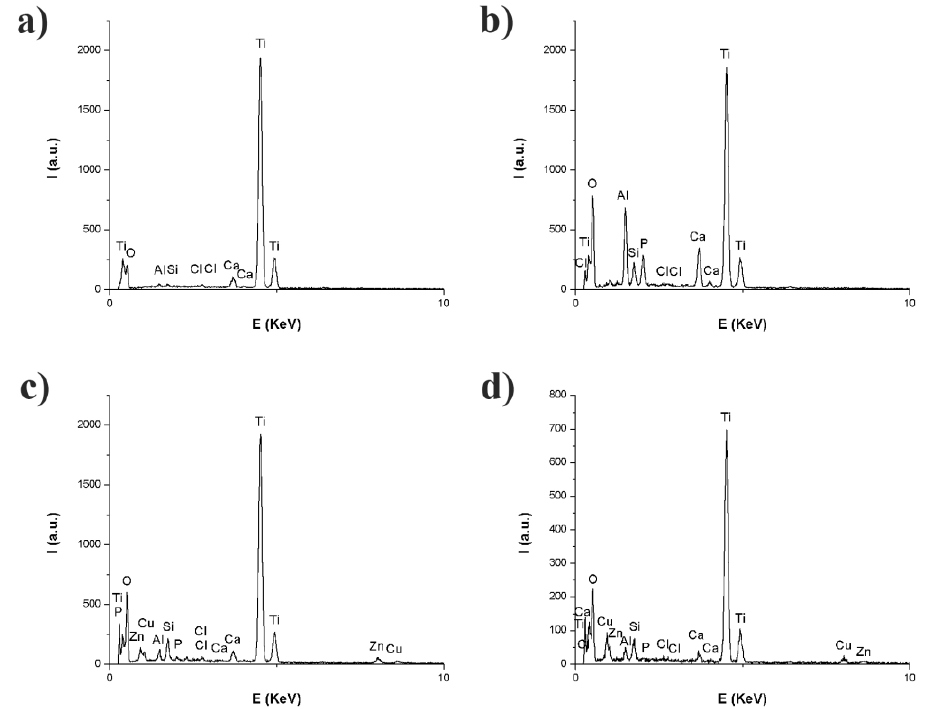
13 of 18 Figure 12. SEM micrograph (10000× magnification) showing implant morphology for ( a ) Samples 1, ( b ) 2, ( c ) 3, and ( d ) 4.